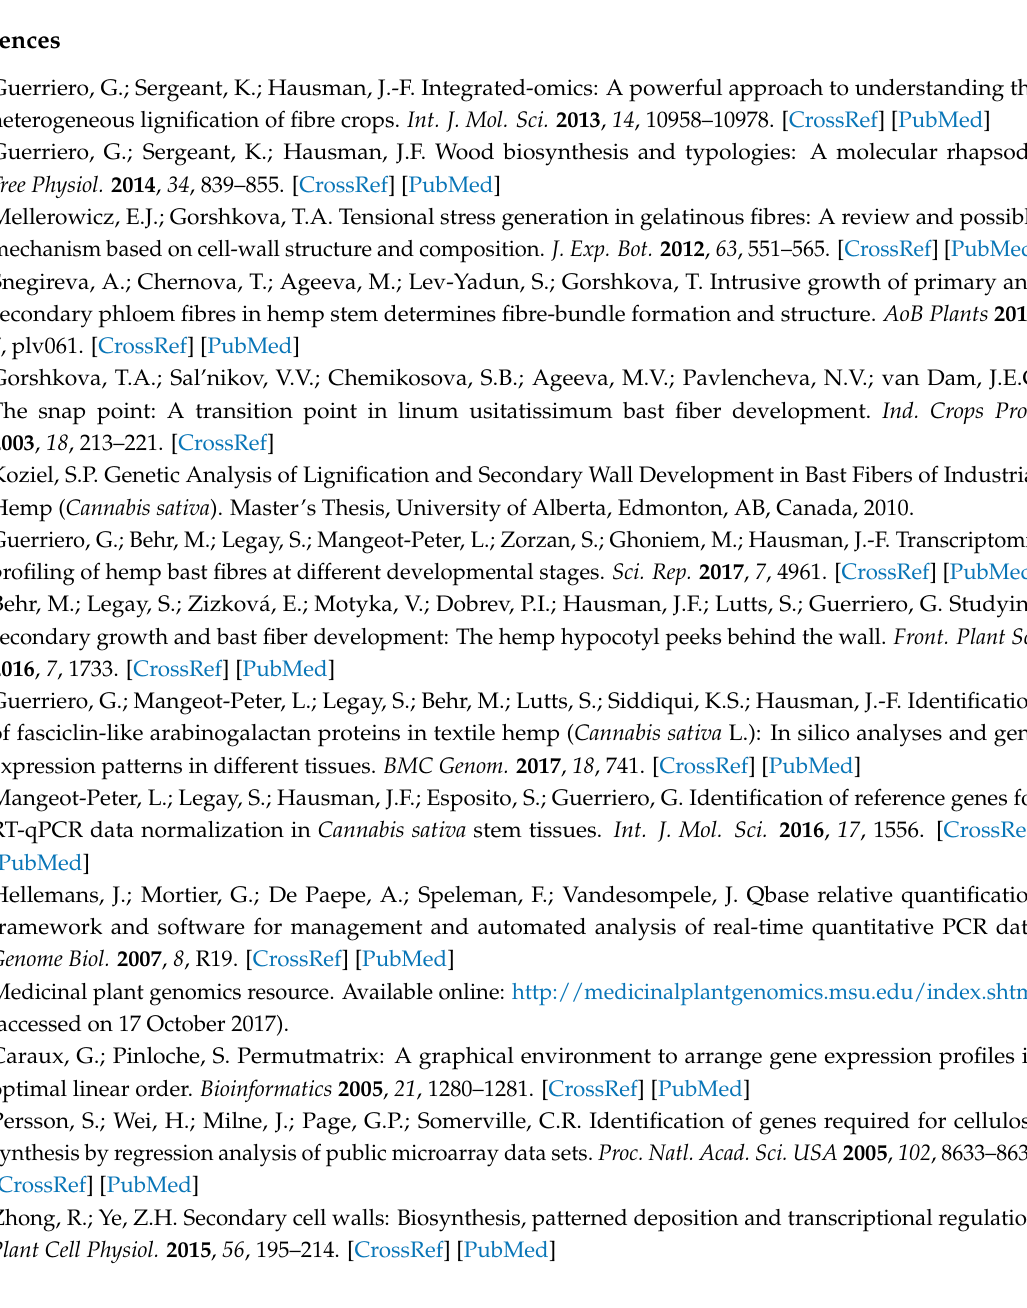
Table S1: Primers and raw gene expression data from Figure